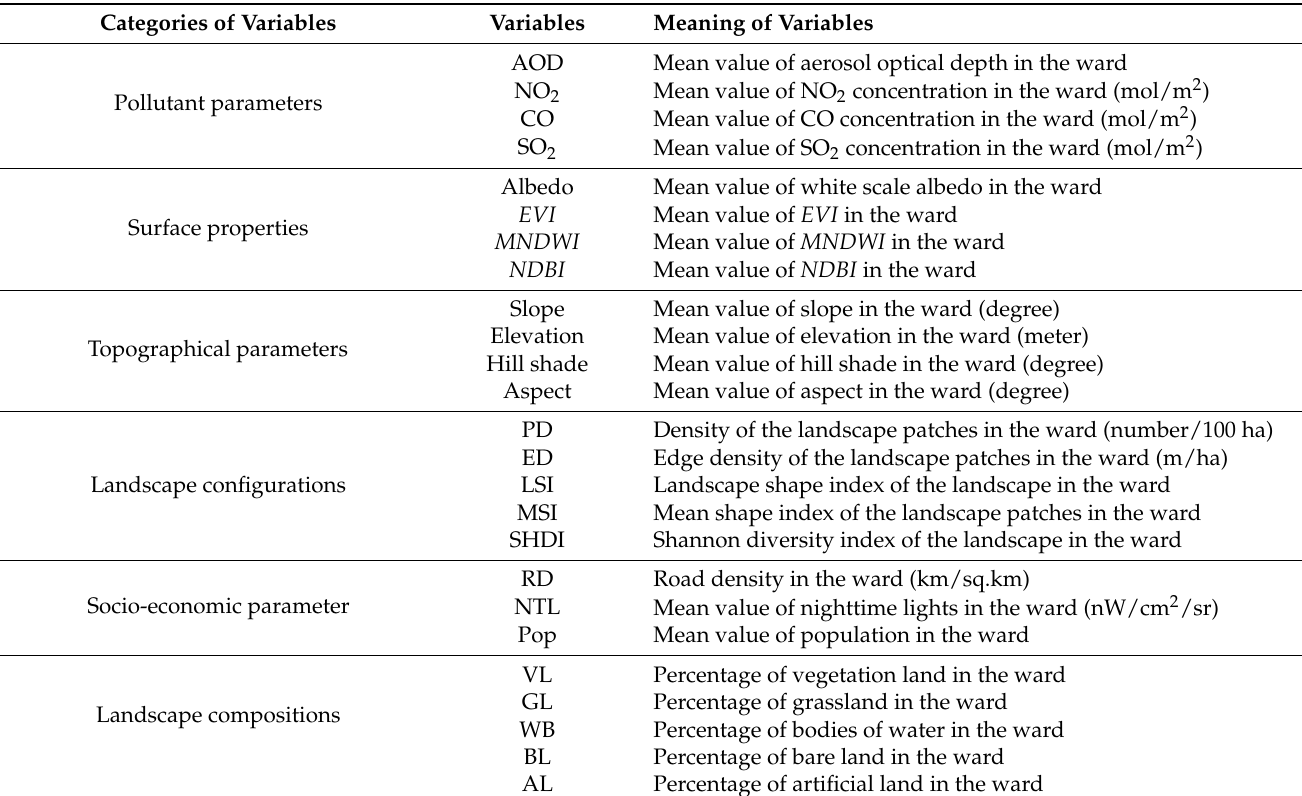
Table 4. Influencing factors of land surface temperature (LST) used in this